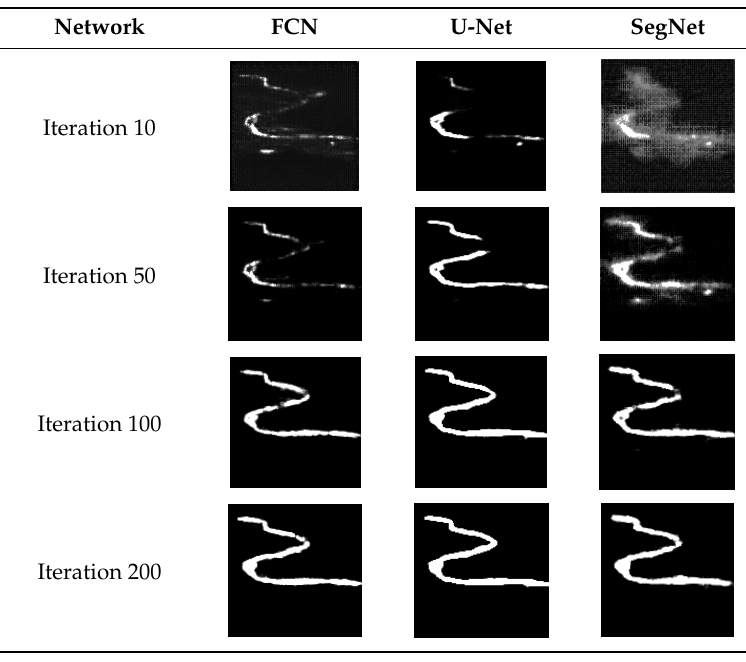
Figure 10. Typical polypropylene training image. Table 4. Training outputs during different epochs.